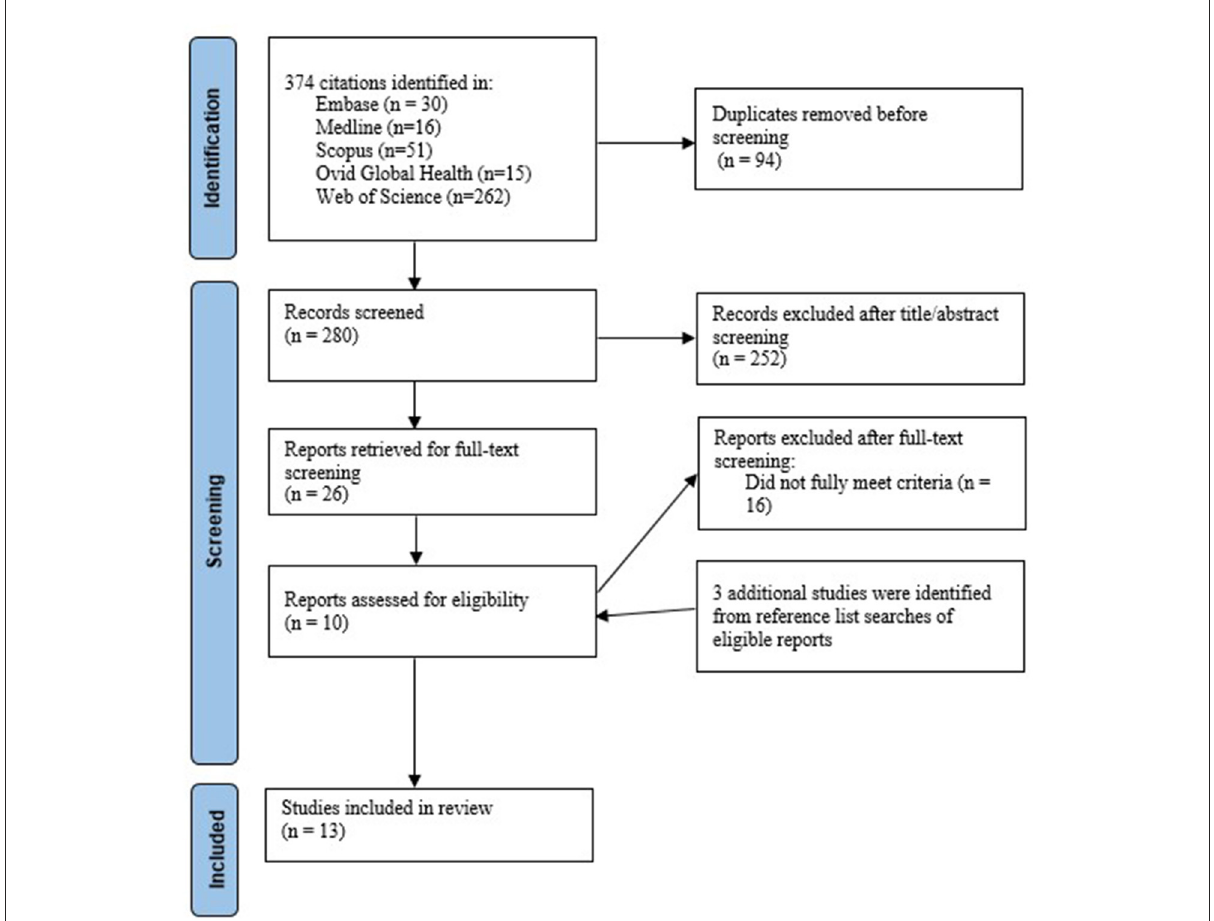
FIGURE1 Flow chart of article